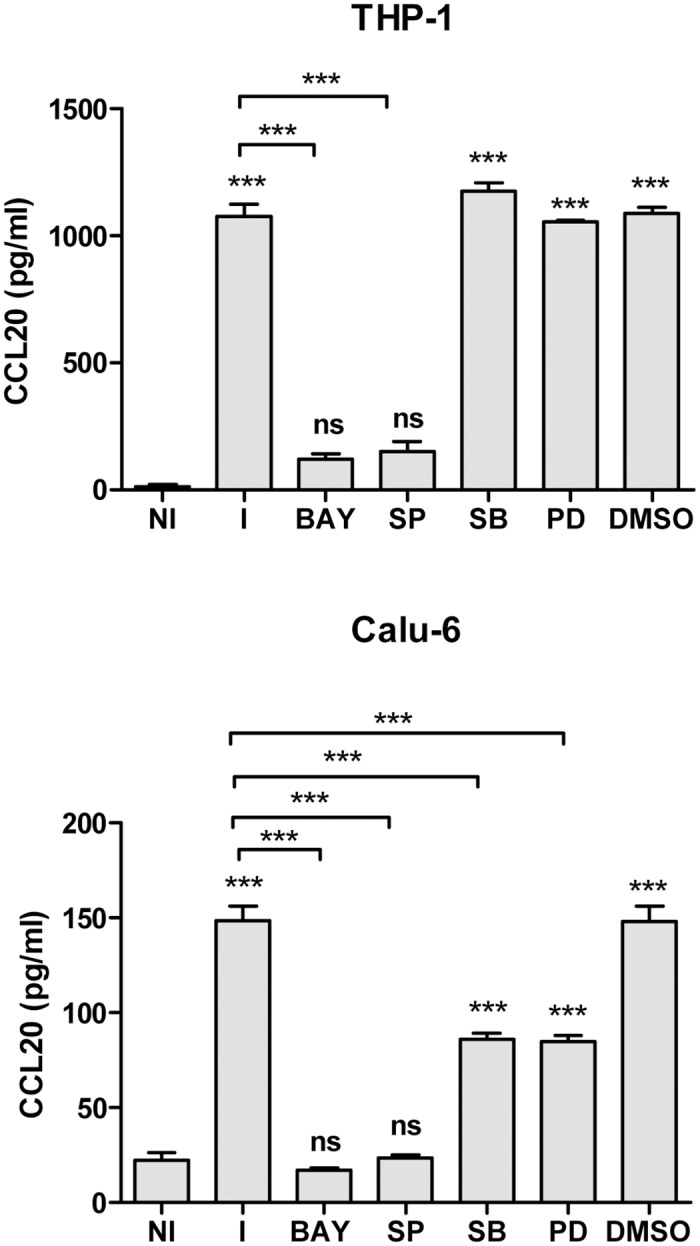
Role of MAPK pathways and NF-κB in CCL20 secretion by Brucella- infected lung epithelial cells and monocytes.Calu-6 and THP-1 cells were incubated with inhibitors of MAPK pathways (PD: inhibitor of Erk1/2; SB: inhibitor of p38 and SP: inhibitor of Jnk1/2) or NF-κB pathways (BAY) 1 h before the beginning of infection and kept throughout. Culture supernatants were harvested at 24 h post infection. NI: non-infected cells. Data are mean ± SEM of four independent experiments. Asterisks above bars indicate statistically significant differences (***, p < 0.001) relative to NI (ANOVA followed by Tukey’s Multiple Comparison test).